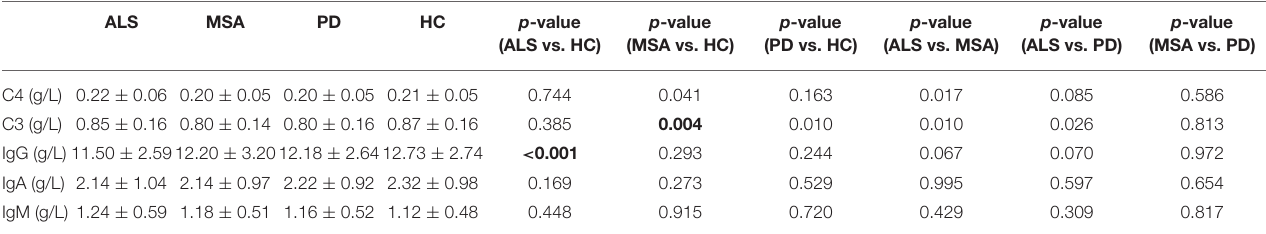
TABLE 2 | Levels of serum immunoglobulin and complement in patients with ALS, MSA, and PD and HCs. ALS MSA PD HC p -value